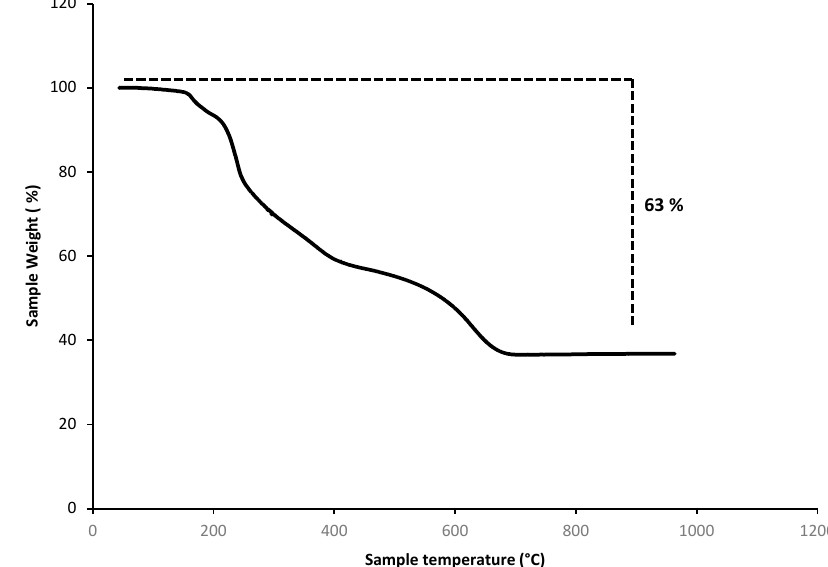
Figure 3. Thermogravimetric analysis of a sample of functionalized AuNP powder.